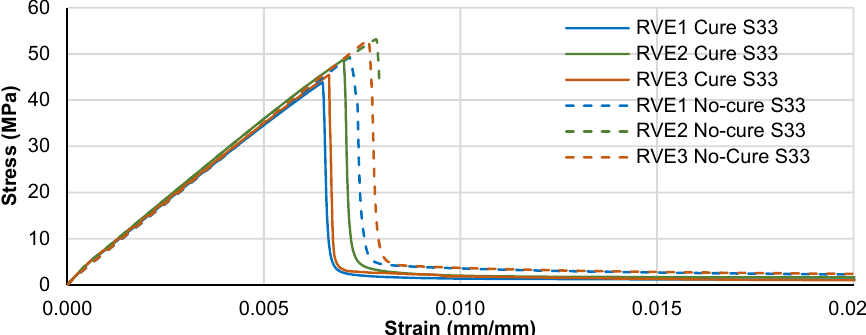
Figure 13. Transverse tensile stress-strain response comparison.